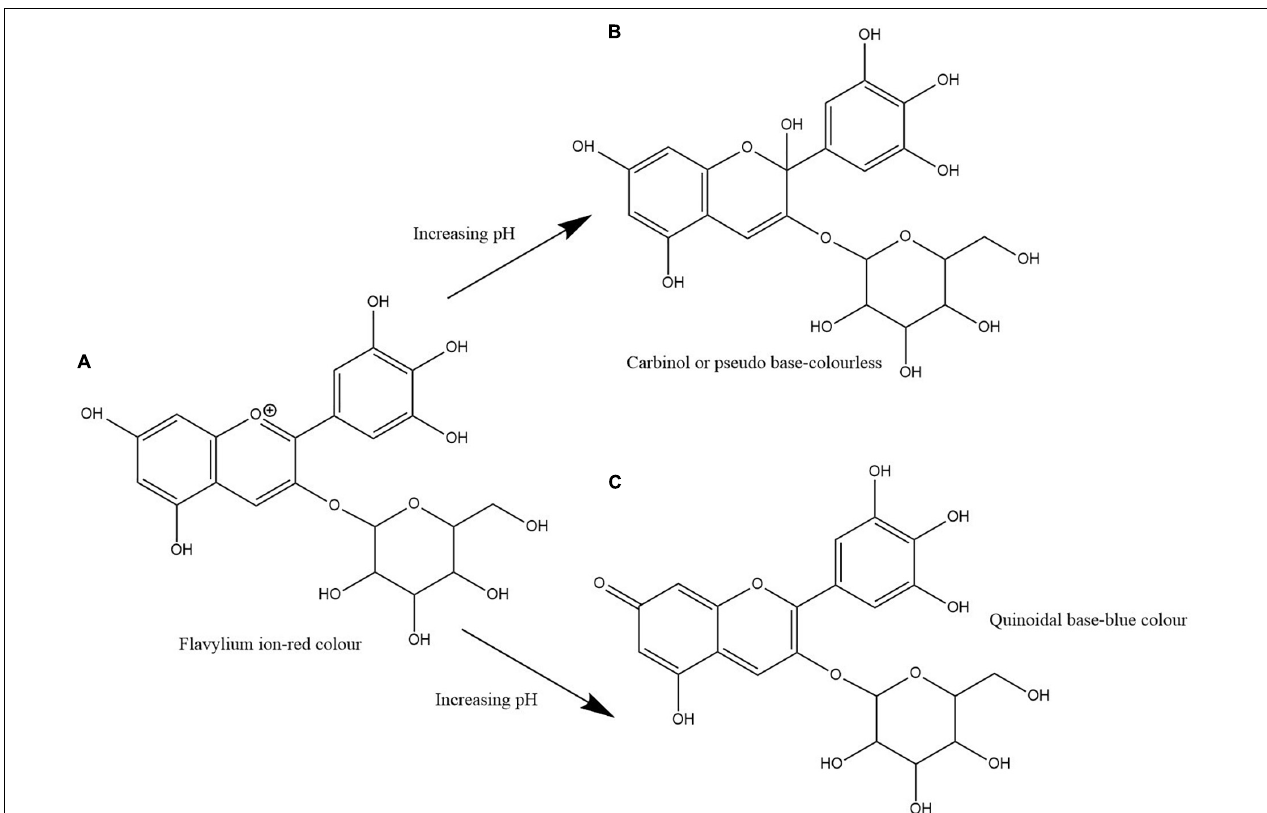
FIGURE 2 | Structural change of delphinidin-3-glucoside with increasing pH. Path (A,B) shows the transformation of flavylium ion to carbinol or pseudo base. Path (A,C) shows the transformation of flavylium ion to quinoidal base. Path (A,C) shows the structural alteration responsible for the blue colour formation in blue pea flower